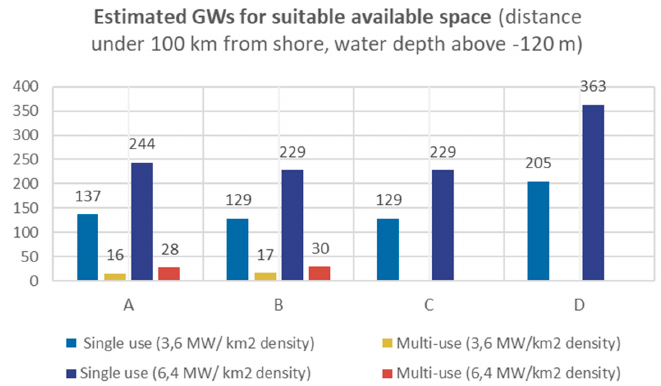
Figure 11. Estimated potential GWs according to the available space in all proposed scenarios.